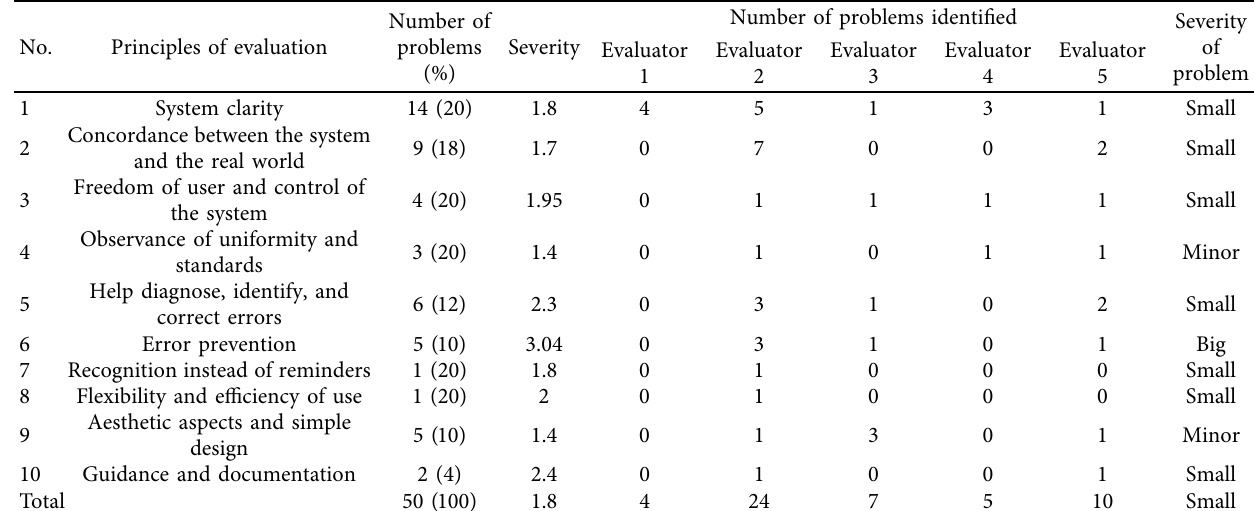
Figure 4: Step of determining the location of tooth in order to enter the data in the DIR. Table 3: Number of usability problems identified based on Nielsen’s evaluation